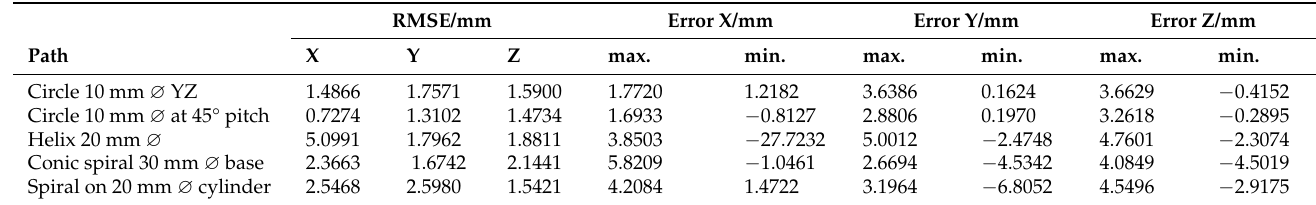
Table 4. Summary table for results of each of the three-DOF tests.